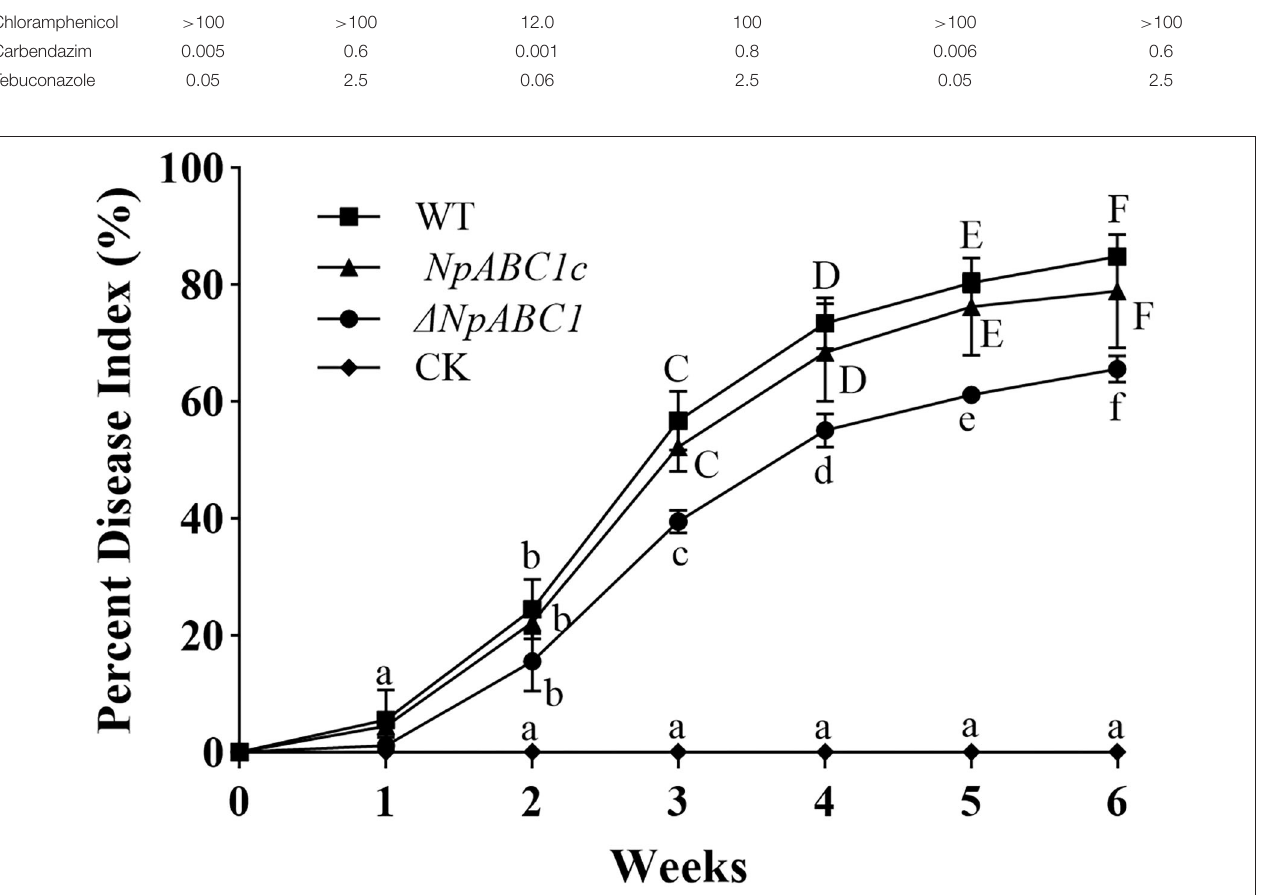
FIGURE 10 | Dynamic changes in the disease index of walnut infected by different strains. WT, plants inoculated with wild-type strain ( (cid:4) ); ∆ NpABC1 , plants inoculated with deletion mutant strain (•); NpABC1c , plants inoculated with complementary strain ( N ); CK, negative control, plants inoculated with sterile water ( (cid:7) ). All assays were repeated three times, and the data were analyzed using one-way ANOVA and Duncan’s range test in SPSS 16.0. Uppercases and lowercases indicate that the disease index of different treatment groups in the same period is significantly different ( p ≤